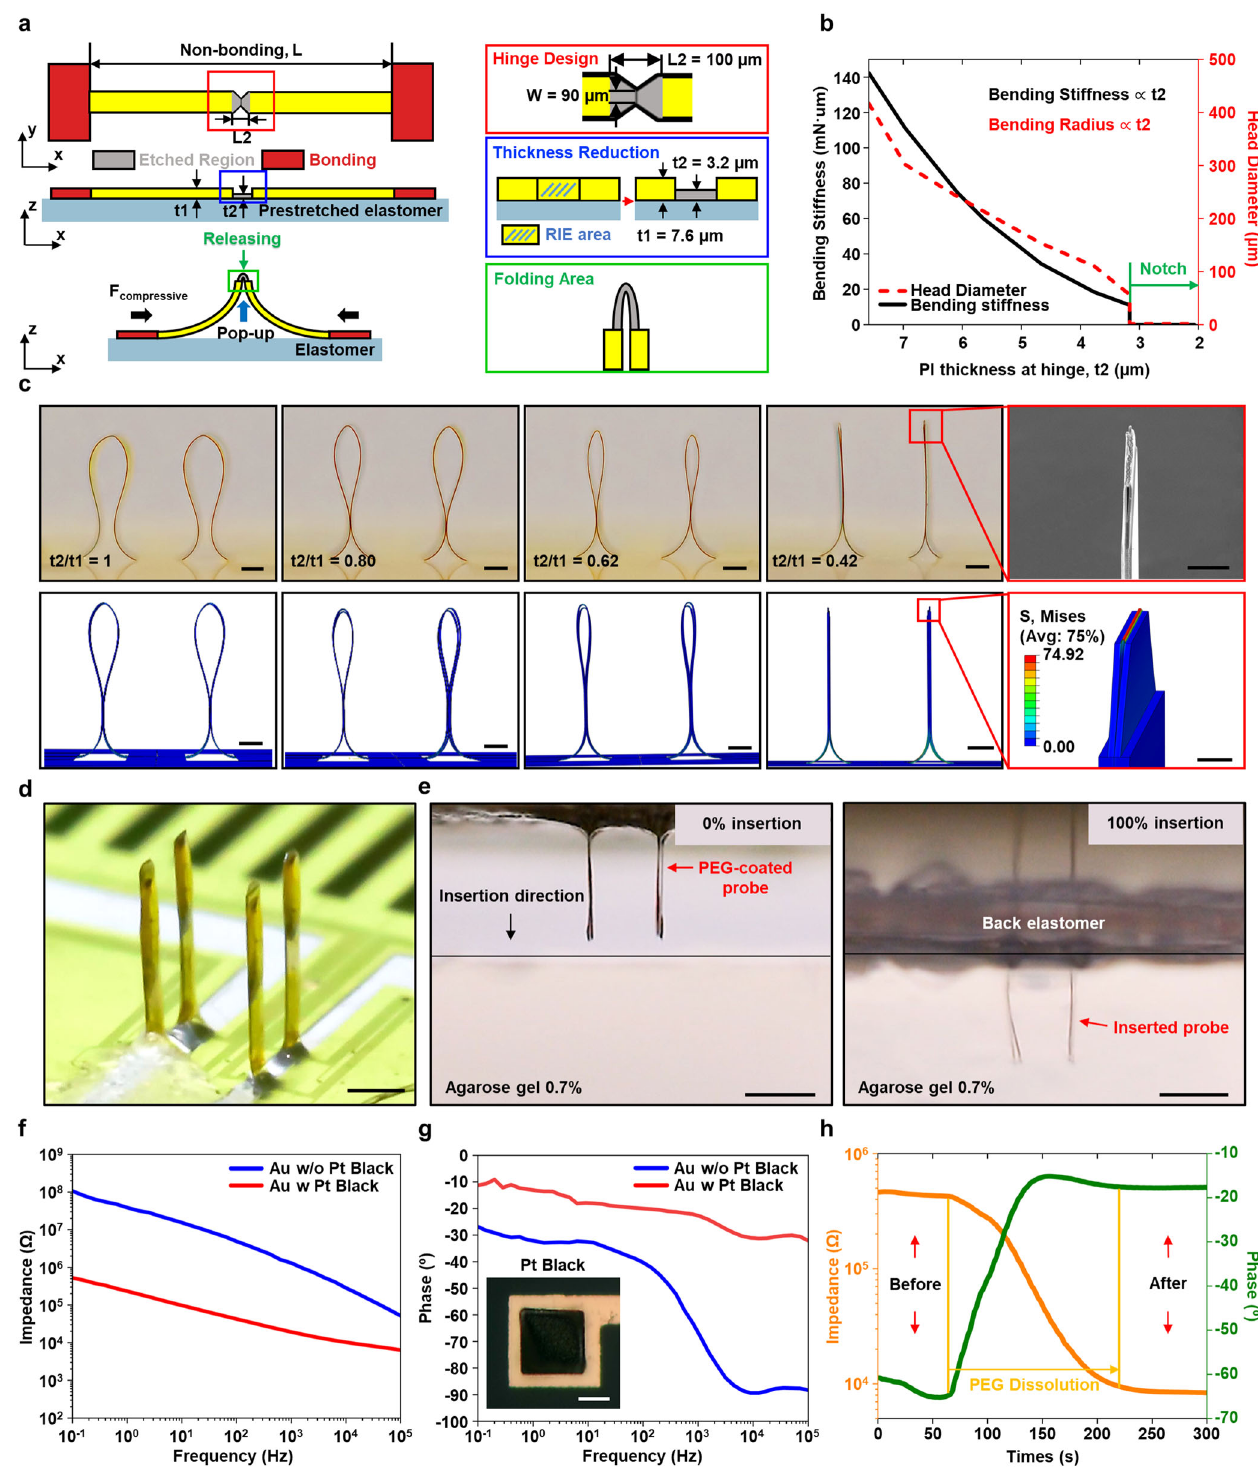
function of the PI thickness in the central etched region. Since the PI thickness at the hinge was decreased by RIE using a metal mask, the folded 3D electrode exhibited a decreasing the tip head diameter and a higher height at the pop-up PI/SU8 bilayer, which was consistent with the experimental measurements. The effective bending stiffness EI of a multilayered structure was associated with the plain-strain Young ’ s modulus E i ¼ E i = ð 1 (cid:2) ν 2